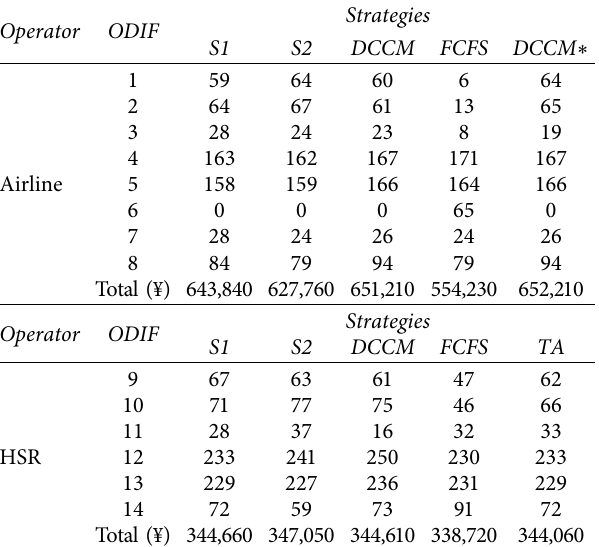
Table 8: Resource supply and